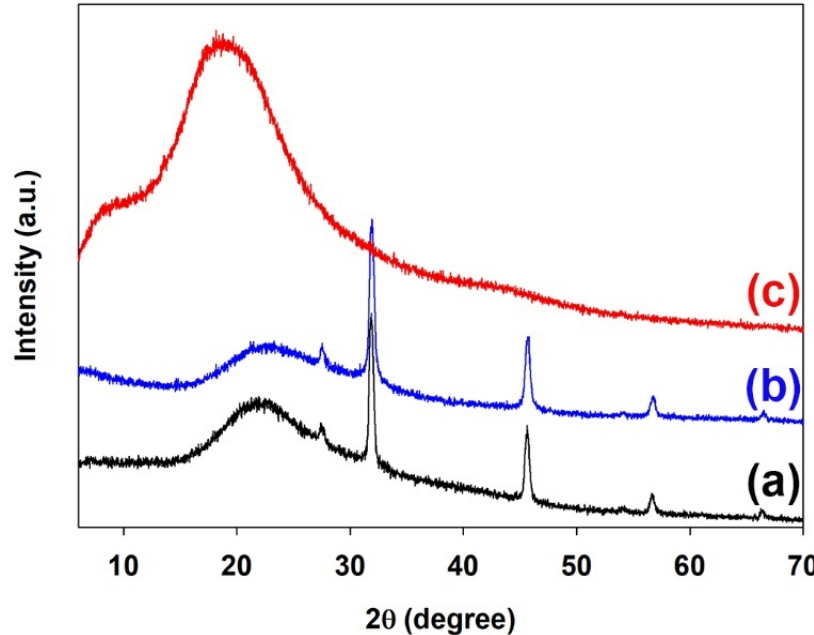
Figure 2. XRD patterns of P(NIPAM-AM) ( a ), OSG/P(NIPAM-AM) ( b ), and OSG ( c ).